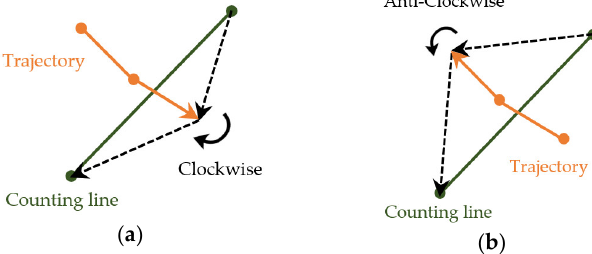
Figure 10. Two cases where the trajectory of the object and the counting line intersect: ( a ) Case 1; and ( b ) Case 2.